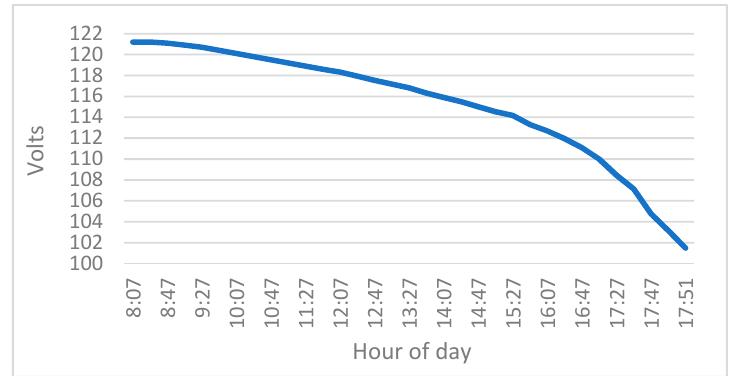
Figure 37. BB voltage in discharge mode.